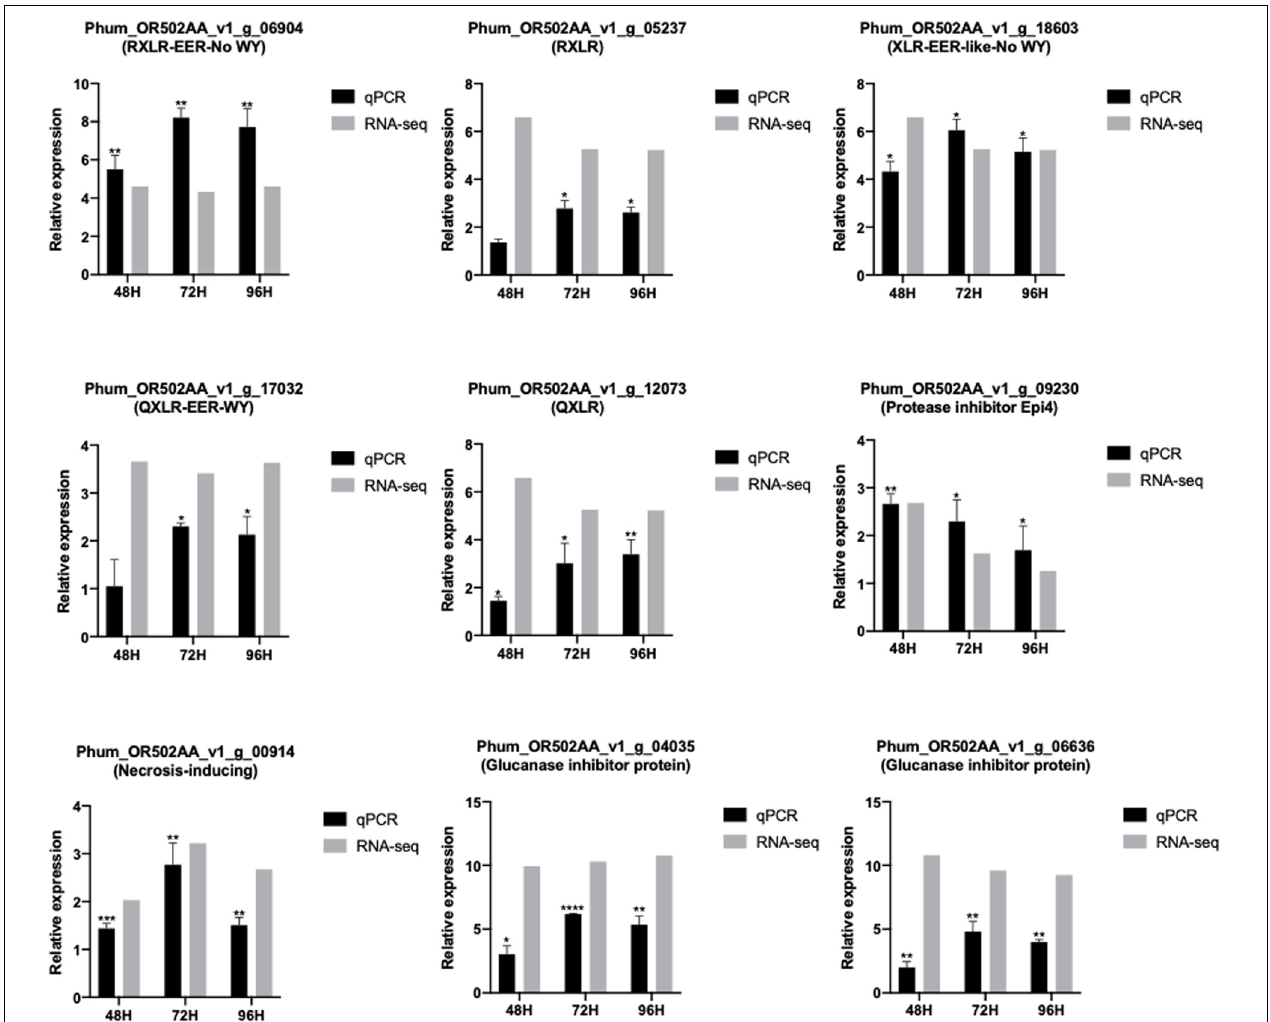
FIGURE 4 | Comparison of RNAseq and RT-qPCR expression values of selected effector genes in different time-points of Pseudoperonospora humuli infection of hop. RNA-seq expression levels are depicted in log2 values of reads per kilobase million (RPKM) values. RT-qPCR expression levels are represented as mean (cid:49)(cid:49) CT values from three independent biological replicates. * P -value < 0.05, ** P -value < 0.01, *** P -value < 0.001, **** P -value < 0.0001. P -values were calculated using a paired t -test in the GraphPad Prism